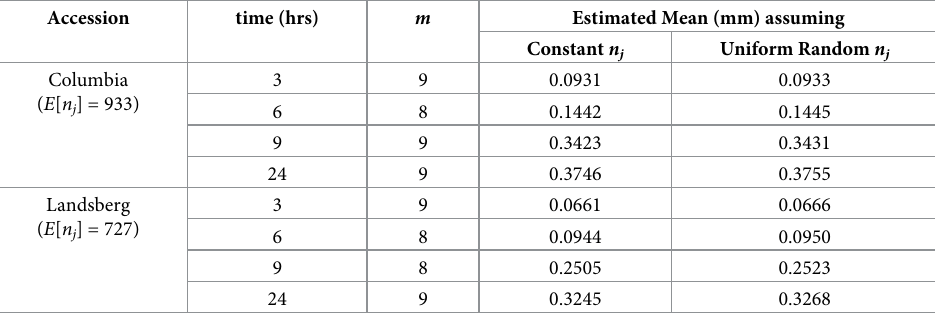
Table 3. The estimated mean pollen tube length in mm, assuming either a constant or uniform random number n of pollen tubes within each of the m